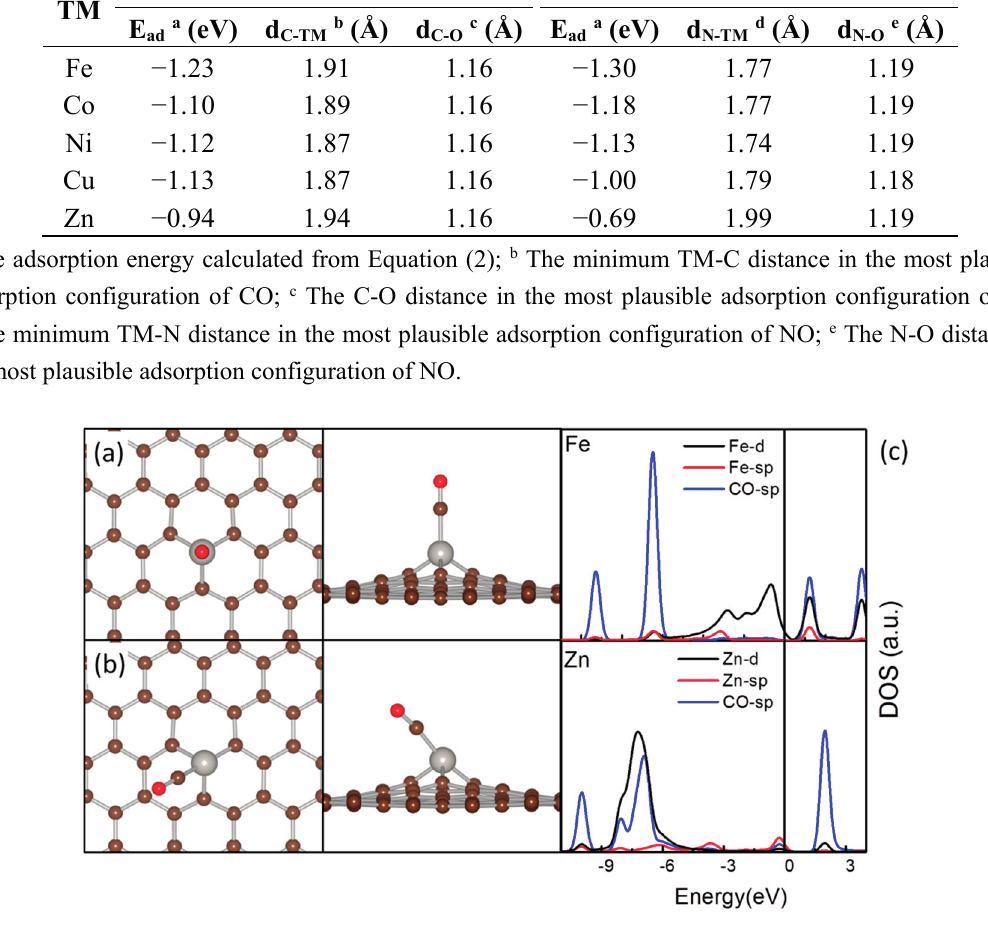
Figure 4. The top view (left panel) and side view (middle panel) of the Tetr’ ( a ) and Octa’ ( b ) configurations for CO and NO adsorption on TM-MGs, and the DOS curves for CO adsorption on Fe-MG and Zn-MG ( c ). In ( a , b ), the C atoms are in brown, the TM atoms are in silver and the O atoms are in red. In ( c ), the DOS curves were aligned by the calculated E F